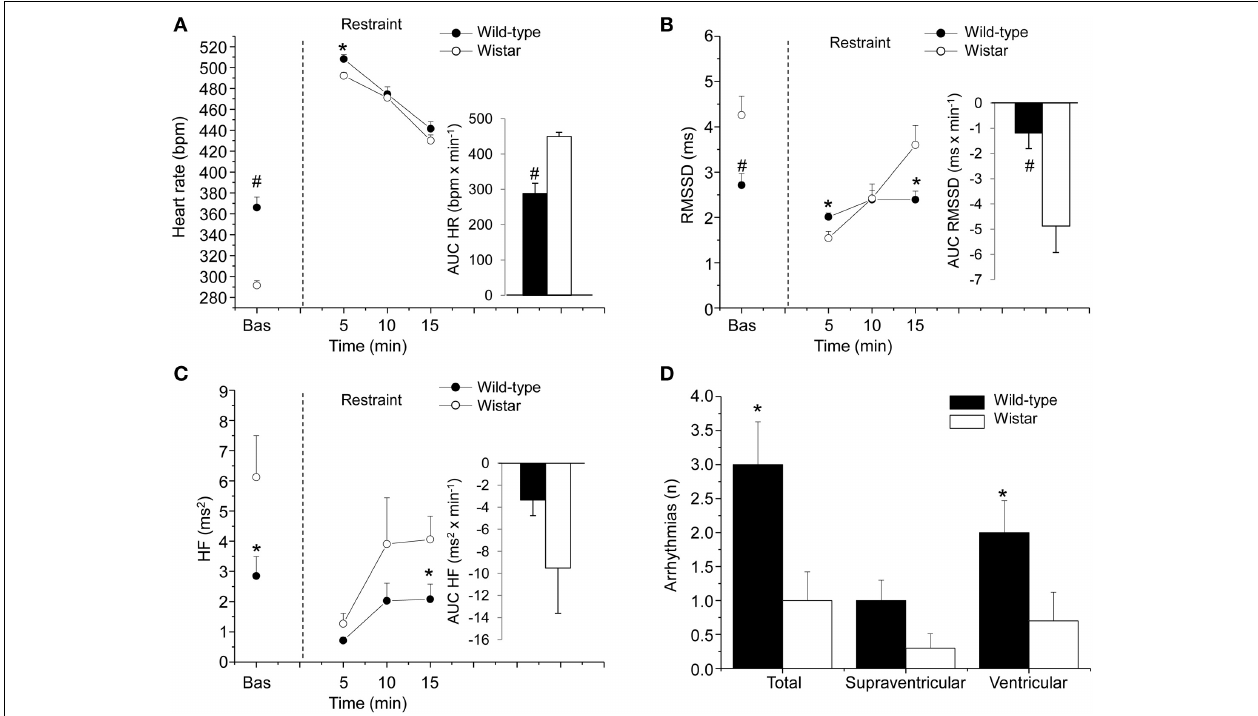
FIGURE 3 | Cardiac response to a restraint stress in 4-month-old Wild-type ( n = 10) and Wistar ( n = 10) rats. Panels (A–C) show the time course of changes in heart rate, RMSSD values, and high-frequency (HF, 0.75–2.5Hz) spectral power, respectively, in baseline conditions (bas, 30min) and during the restraint test (15min). Each point during the restraint phase is the mean of 5-min intervals. Inner graphs in (A–C) represent the area under